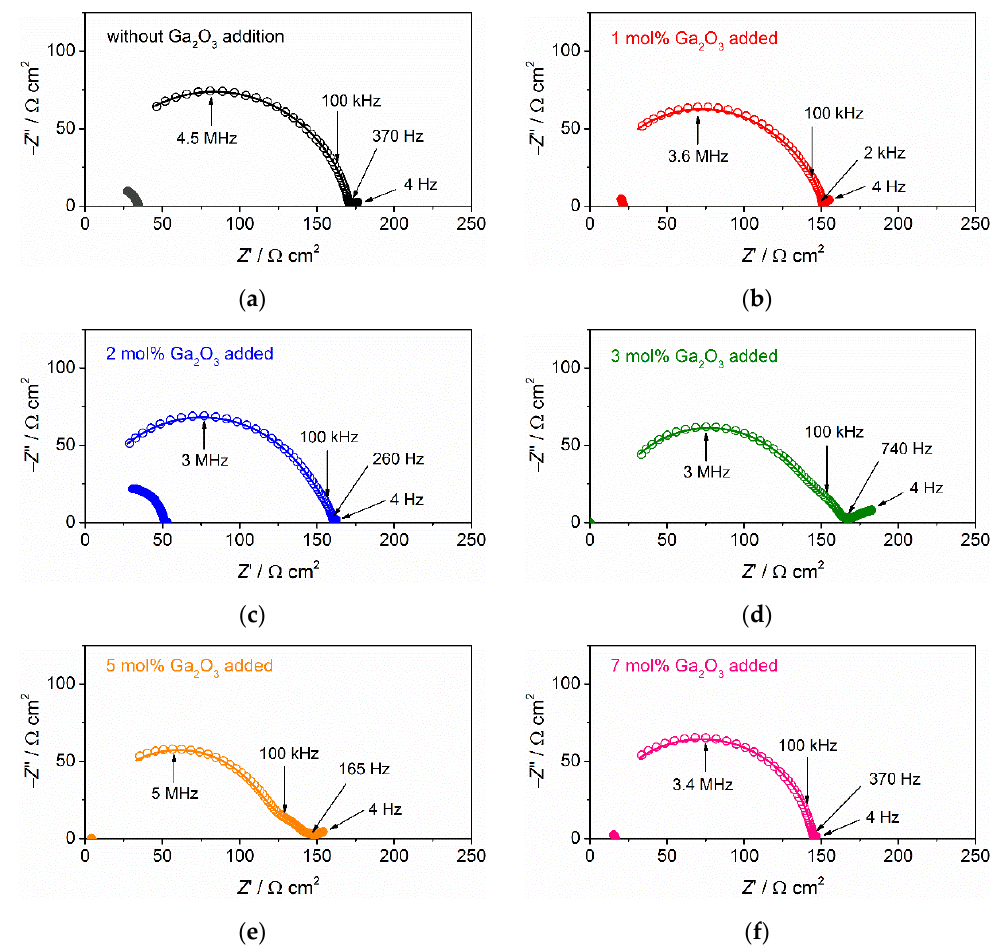
Figure 6. Nyquist plots for complex impedance Z ’ + j Z ” at 27 °C in symmetric cells composed of Li metal electrodes and Ta-doped LLZO: ( a ) without Ga 2 O 3 addition, ( b ) 1 mol % Ga 2 O 3 addition, ( c ) 2 mol % Ga 2 O 3 addition, ( d ) 3 mol % Ga 2 O 3 addition, ( e ) 5 mol % Ga 2 O 3 addition and ( f ) 7 mol % Ga 2 O 3 addition. Blank and solid symbols correspond to the impedance data before and after the galvanostatic cycling test, respectively. The solid lines are the fitting curves for the data before galvanostatic testing by the equivalent circuit.